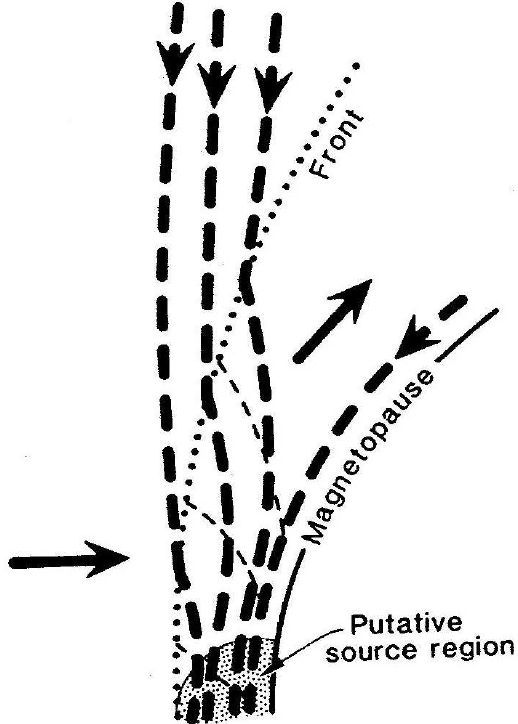
Fig. 1. Taken from Southwood and Kivelson (1992). A sketch shows the flow structure upstream of the subsolar magnetopause. There is a field compression region with roughly the properties of Zwan and Wolf (1976)’s flux tube immediately adjacent to the mag- netopause. However, the field is not aligned with the outer boundary of the region. Field lines threading the compression regions bend toward the Sun and enter a field rarefaction region which is imme- diately behind a slow MHD wave front. Outside the front the field threads the incoming magnetosheath flow.